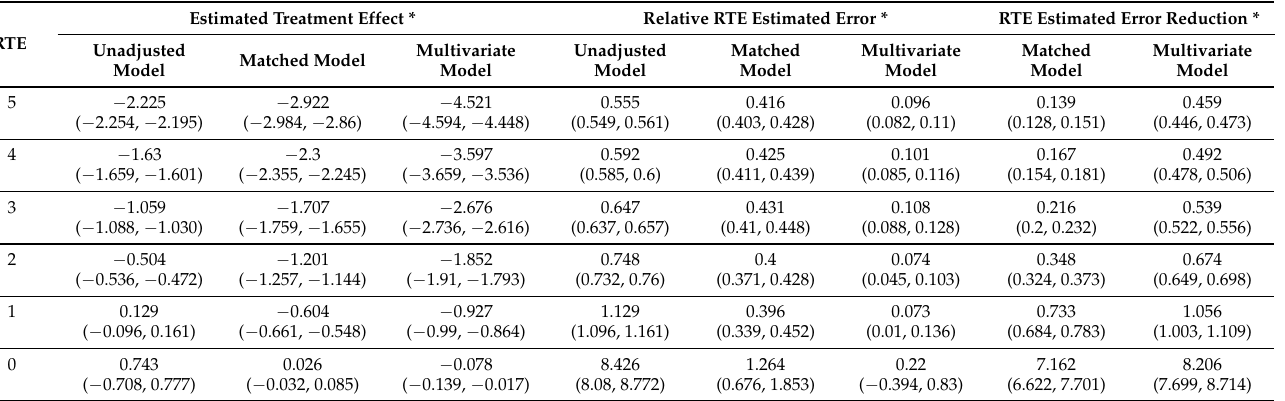
Table 2. Real Treatment Effect Estimation for the Unadjusted Multivariate and Propensity Score Matching models. RTE: Real Treatment Effect Estimation; T-S Bias: Treatment Selection Bias. In brack- ets: 95% confidence